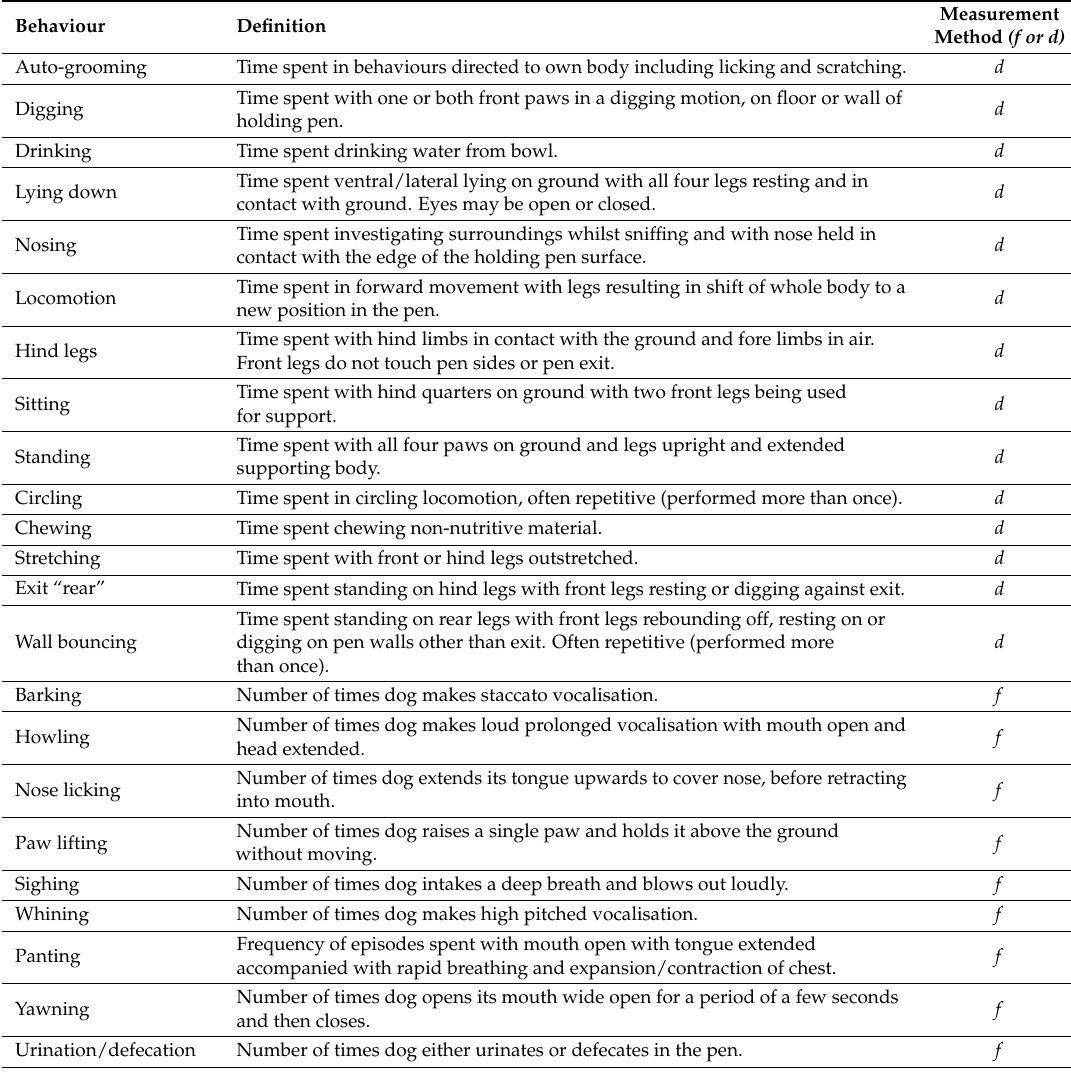
Table 1. Ethogram of behaviours, measured as frequencies ( f ) (events) or durations ( d ) (states). Behaviour Definition